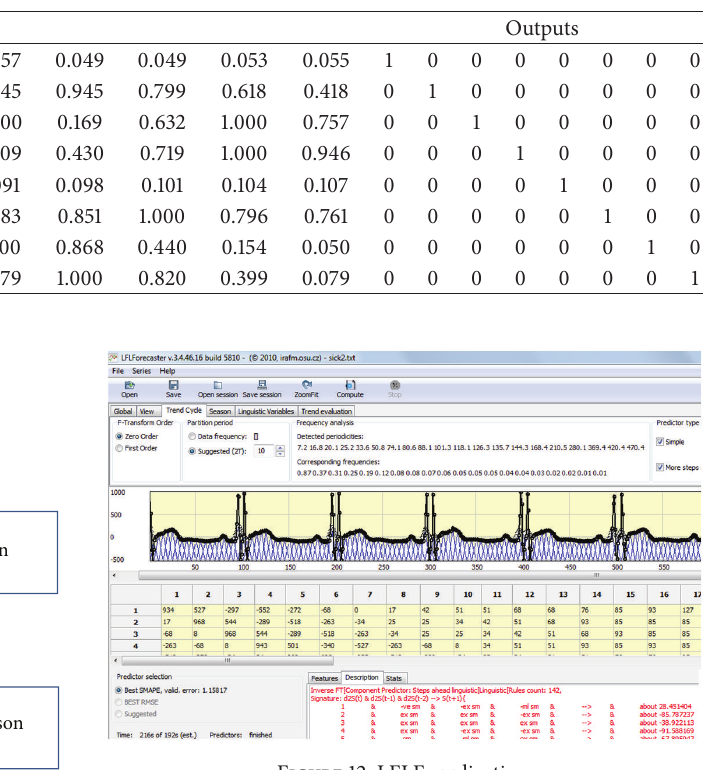
Figure 12: LFLF application.